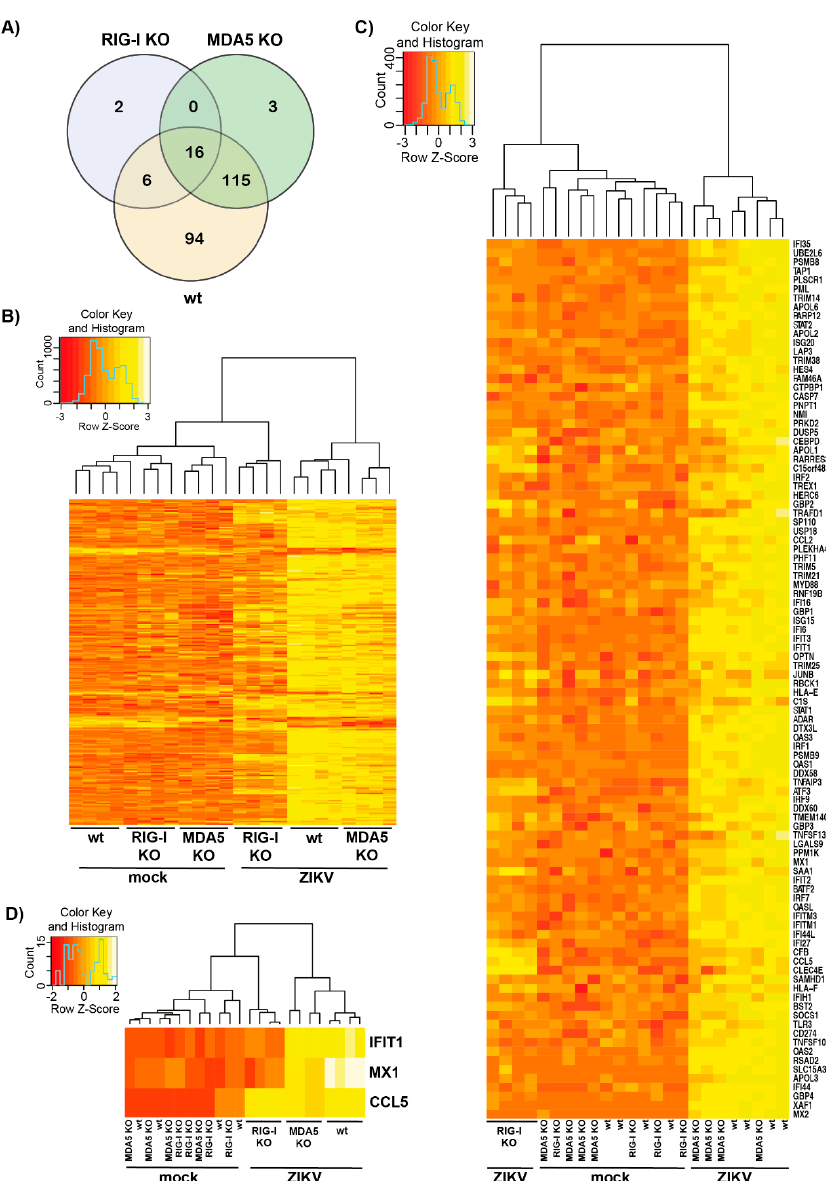
Figure 2. RIG-I sensing drives most transcriptional changes upon ZIKV infection. ( A ) Venn diagram showing differentially expressed genes in wt, RIG-I KO and MDA5 KO cells 24 h after infection; ( B – D ) Heat maps depicting all 236 differentially expressed genes ( B ), 98 differentially expressed ISGs ( C ) and three exemplary ISGs with different expression profiles in A549 wt, RIG-I KO and MDA5 KO cells upon ZIKV infection ( D ). Colors represent z -scores that indicate a value's relationship to the mean, measured as standard deviations from the mean. z -scores calculated for each row (i.e., each gene) and were plotted instead of the normalized expression values to ensure that expression patterns are not overwhelmed by absolute expression values. Data in A – D pooled from four independent biologic samples.